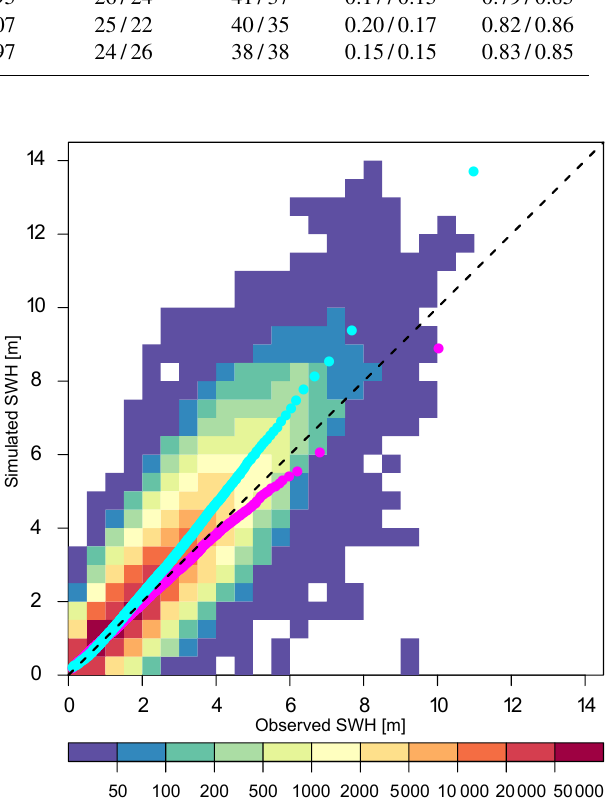
Figure 6. Scatter and quantile–quantile plot of SWH (in metres) between altimeter (GLOBWAVE) observation ( x -axis) and coast- Dat2 hindcast data ( y -axis). Coloured squares indicate the number of the data in each 0.5m × 0.5m bin. Coloured dots represent the percentile values of the quantile–quantile plots between observed and coastDat2 hindcast significant wave heights (cyan) and between observed and ERA-Interim SWH